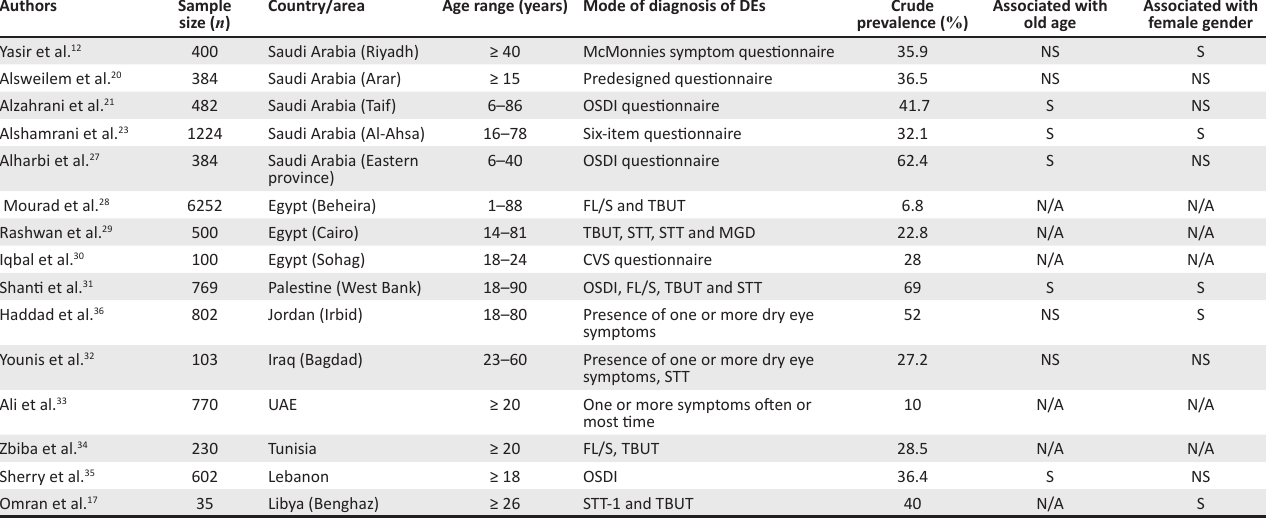
TABLE 1: Summary of Arab studies on the prevalence of dry eyes from 2017 to